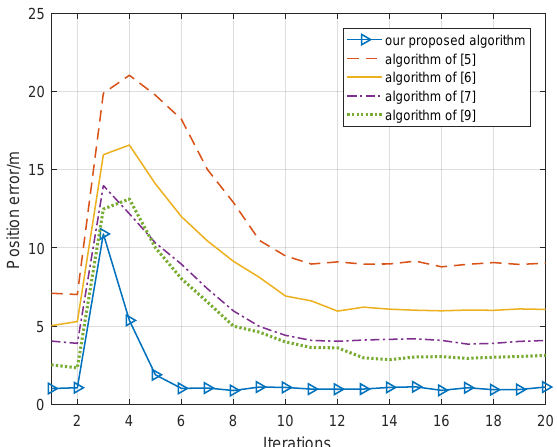
Figure 7. Cooperative position performance with mutation